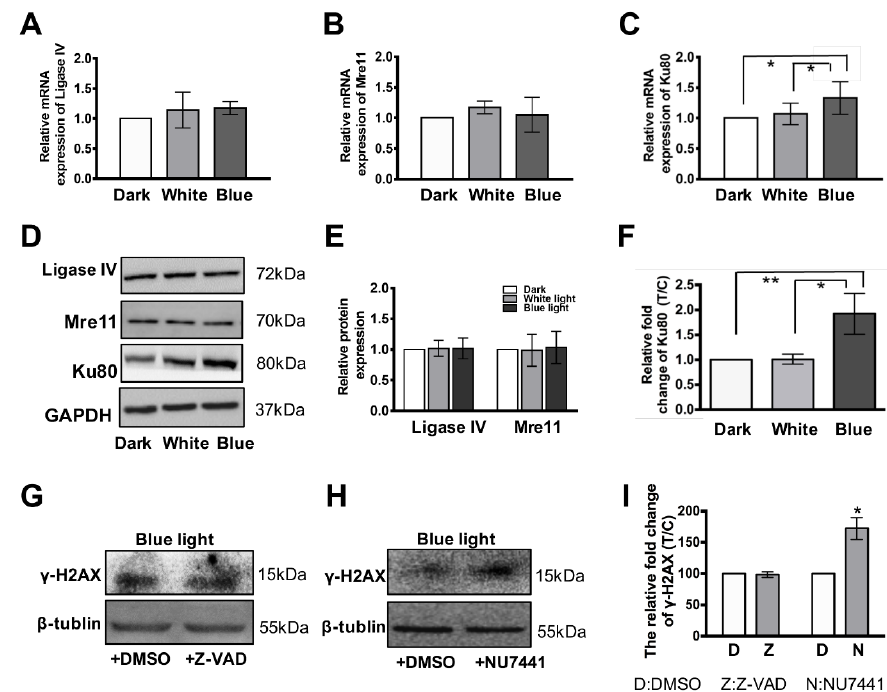
Figure 4. Blue light up-regulated Ku80 expression in glia cells. ( A ) Both blue light and white light treatment do not affect the mRNA expression of ligase IV in primary cultured retinal cells. ( B ) Both blue light and white light treatment do not affect the mRNA expression of Mre11 in primary cultured retinal cells. ( C ) The mRNA expression of Ku80 is significantly up-regulated in primary cultured retinal cells upon blue light exposure, compared with control and white light treatment. ( D ) The Ku80 protein expression is significantly up-regulated in primary cultured retinal neurocytes upon blue light exposure, compared with control and white light treatment. While the light treatment does not affect the protein expression of ligase IV and Mre11. ( E ) The relative protein expression of ligase IV and Mre11 are presented as histogram. ( F ) The relative protein expression of Ku80 were presented as a histogram. ( G )The pan-caspase inhibitor, Z-VAD FMK did not affect the γ -H2AX formation in retinal neurocytes c induced by blue light. ( H ) The DNA repair inhibitor, NU7441, further promoted the γ -H2AX foci formation in retinal neurocytes upon blue light treatment. ( I ) The relative protein expression γ -H2AX is presented as a histogram. Error bars represent mean ± SD. Asterisks indicate statistically significant differences between control and experimental samples (* p < 0.05, ** p <